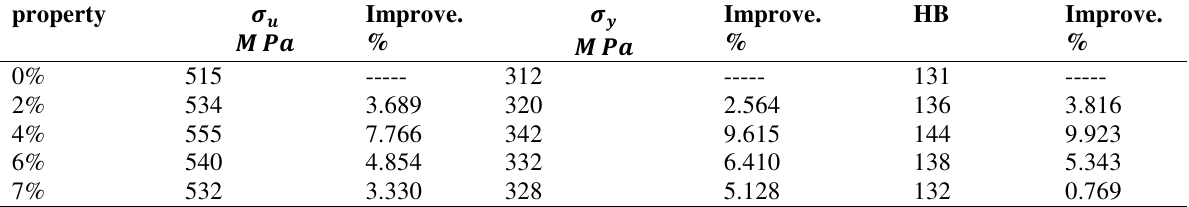
Mechanical properties result for composite 7049AA with different (cid:11) (cid:20) % of ZrO 2 .